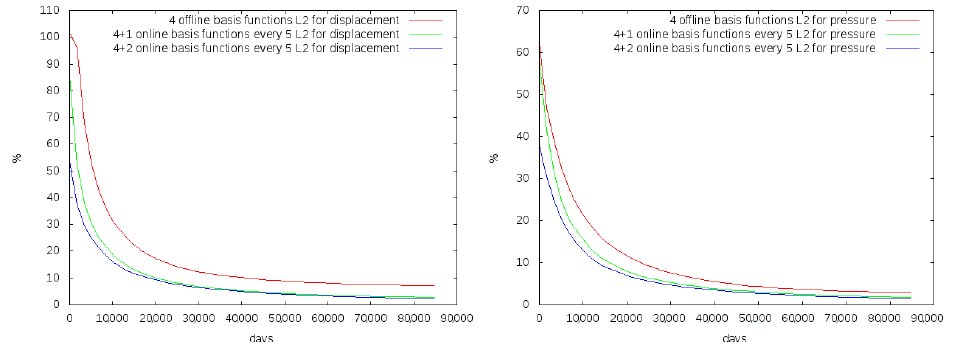
Figure 13. Case 2 . Relative L 2 error vs. time with M of f = 4 for displacements ( left ) and pressure ( right ). M on = 0 (red color), M on = 1 (green), and M on = 2 (blue). Updated at every 5 time